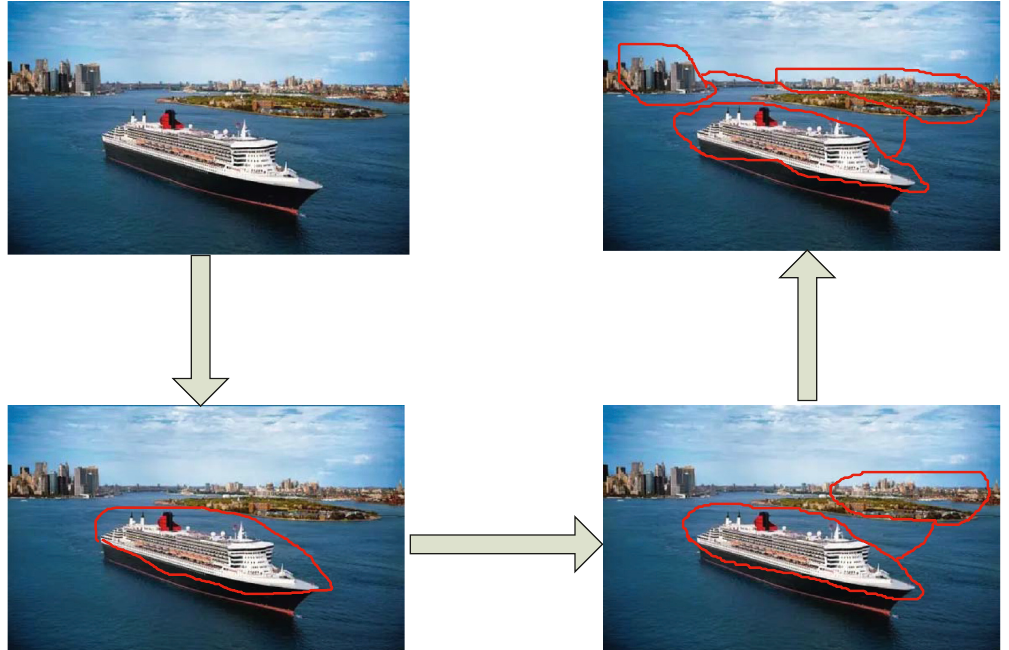
Figure 5: Visual focus shift